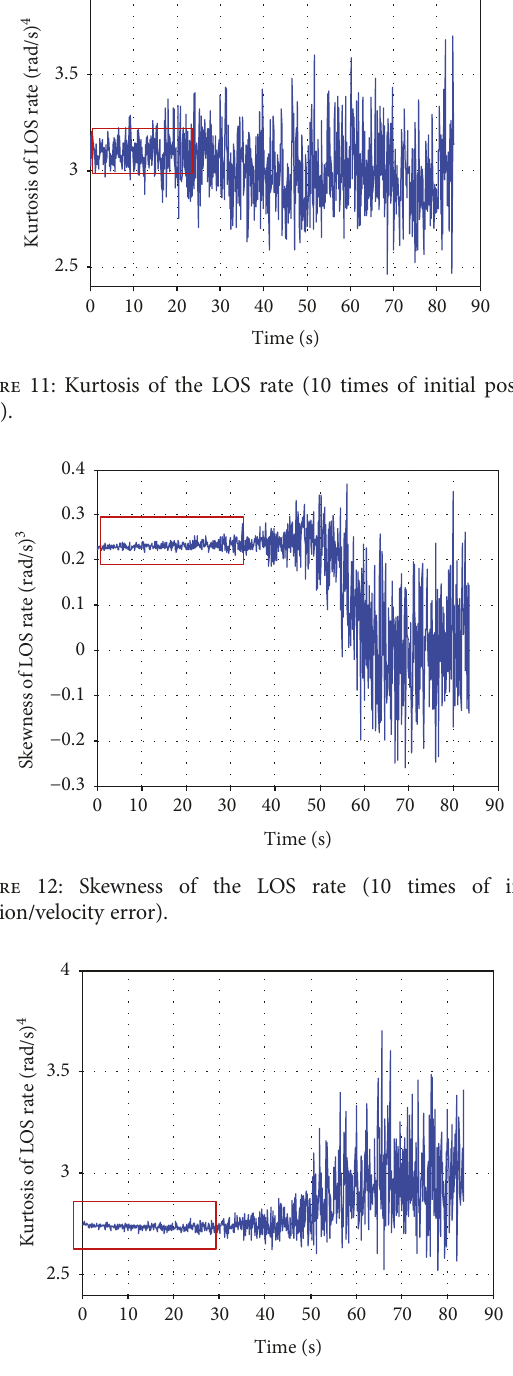
Figure 13: Kurtosis of the LOS rate (10 times of initial position/velocity